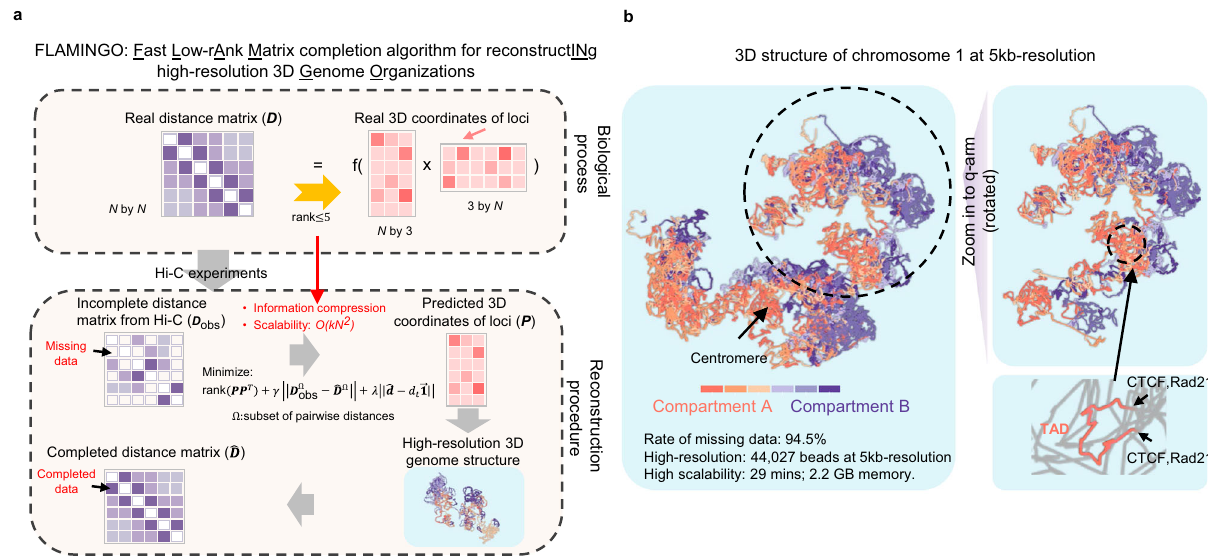
Fig. 1 FLAMINGO reconstructs high-resolution 3D genome structures from Hi-C data. a Schematic fi gure of FLAMINGO. Biologically, the distance matrix (size N by N ) is induced by the 3D coordinate matrix of DNA fragments (size N by 3), which guarantees that the rank of the distance matrix is no more than fi ve (upper panel). The low-rank property suggests the potential of information compression ( N 2 entries to 5 N entries), and enables FLAMINGO to ef fi ciently reconstruct structures from incomplete distance matrices and perform superiorly against large portions of missing data. Equipped with high scalability, FLAMINGO can quickly predict the optimal coordinate matrix that reproduces the observed distances from Hi-C data (middle panel), leading to the high-resolution 3D genome structure and the completed distance matrix (lower panel). b Reconstructed 5 kb-resolution structure of chromosome 1 in the human genome by FLAMINGO. Chromatin compartments (A: orange; B: blue) demonstrate polarized positioning in the predicted structure. A representative example of predicted loop structures is shown in the zoom-in view, where both anchors interact with each other (supported by ChIA-PET interactions) and are bound by CTCF and Rad21. Color gradients represent consecutive TADs within each type of